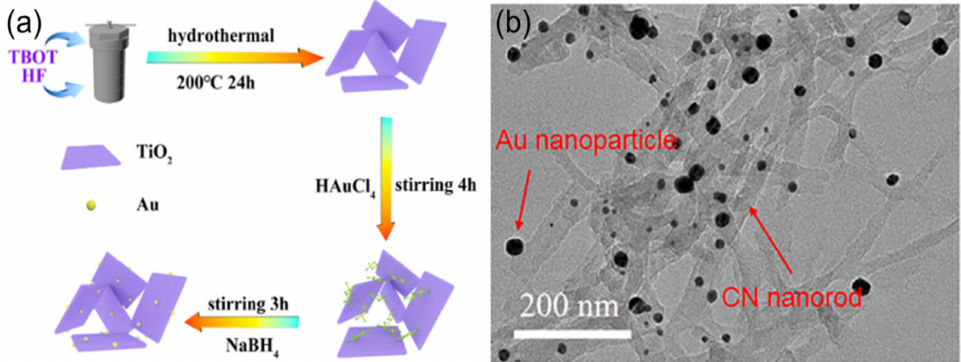
Figure 2. ( a ) Schematic representation of the fabrication of Au/TiO 2 (Reprinted from [64] with permission of Elsevier, 2019) and ( b ) TEM image of 1%Au-CN nanorods (Reprinted from [66] with permission of Elsevier,